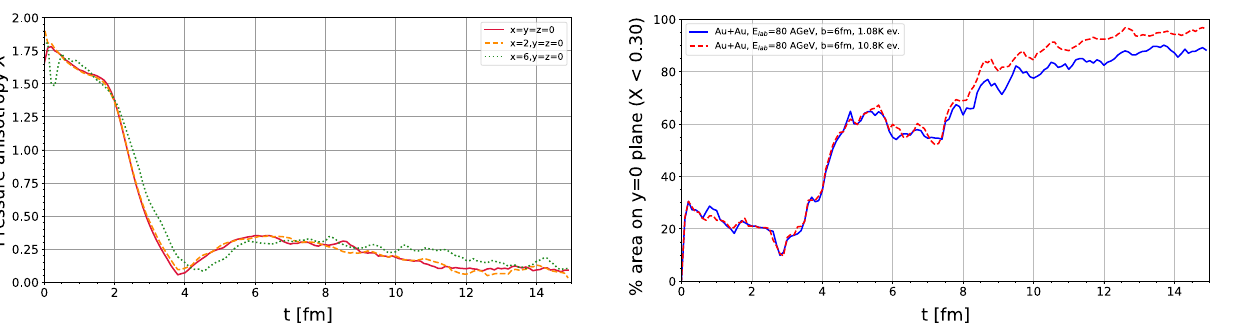
Fig. 27 Comparison between the time evolution of the percentage of the system laying on the xz plane that fulfills the condition X < 0 . 3 when considering 1080 or 10,800 events. The Figure refers to Au+Au collisions at E lab = 80 AGeV, b = 6